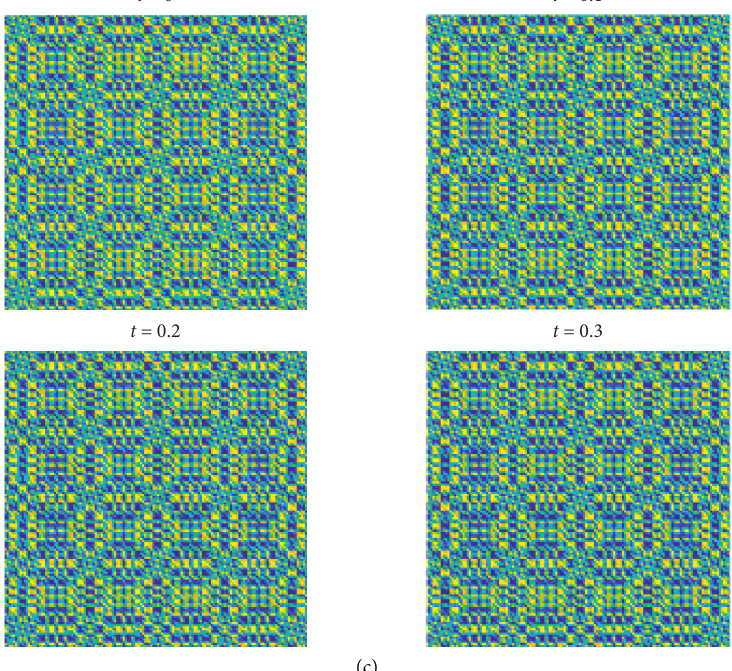
Figure 7: Numerical solution and pattern of Experiment 1 with initial condition η ( x,y, 0 ) � 0 . 8sin ( sin ( y 2 − x 2 )) + 0 . 2.